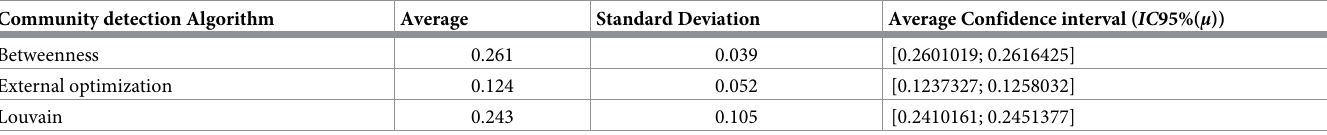
Table 4. Descriptive statistics of Community detection algorithms modularity applied to 10000 random graphs with the same vertices and links as the curriculum network (null model). Community detection